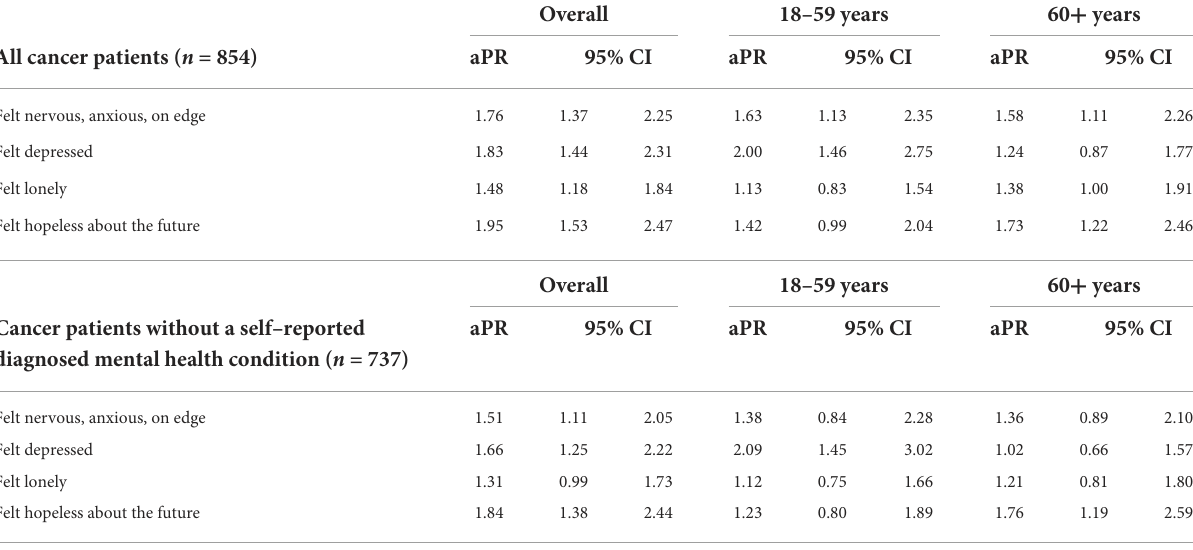
TABLE 4 Associations of financial hardship with mental health symptoms experienced at least 1 day in the past week among cancer survivors by age groups among COVID Impact Survey cancer survivors, a nationally representative survey of the US (April–June